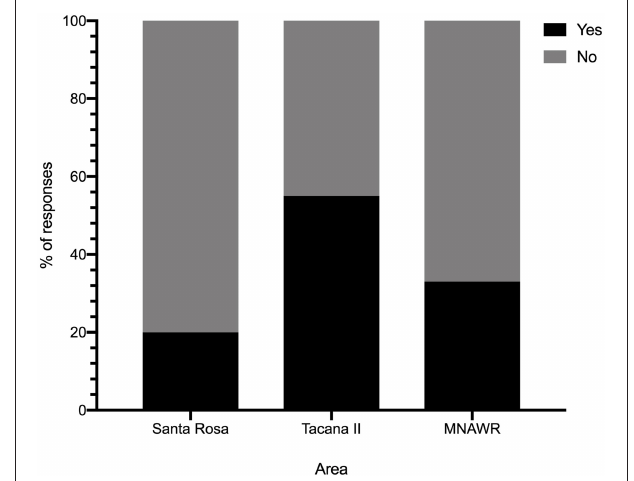
FIGURE 3 | Proportion of residents who reported killing a jaguar in the past, by